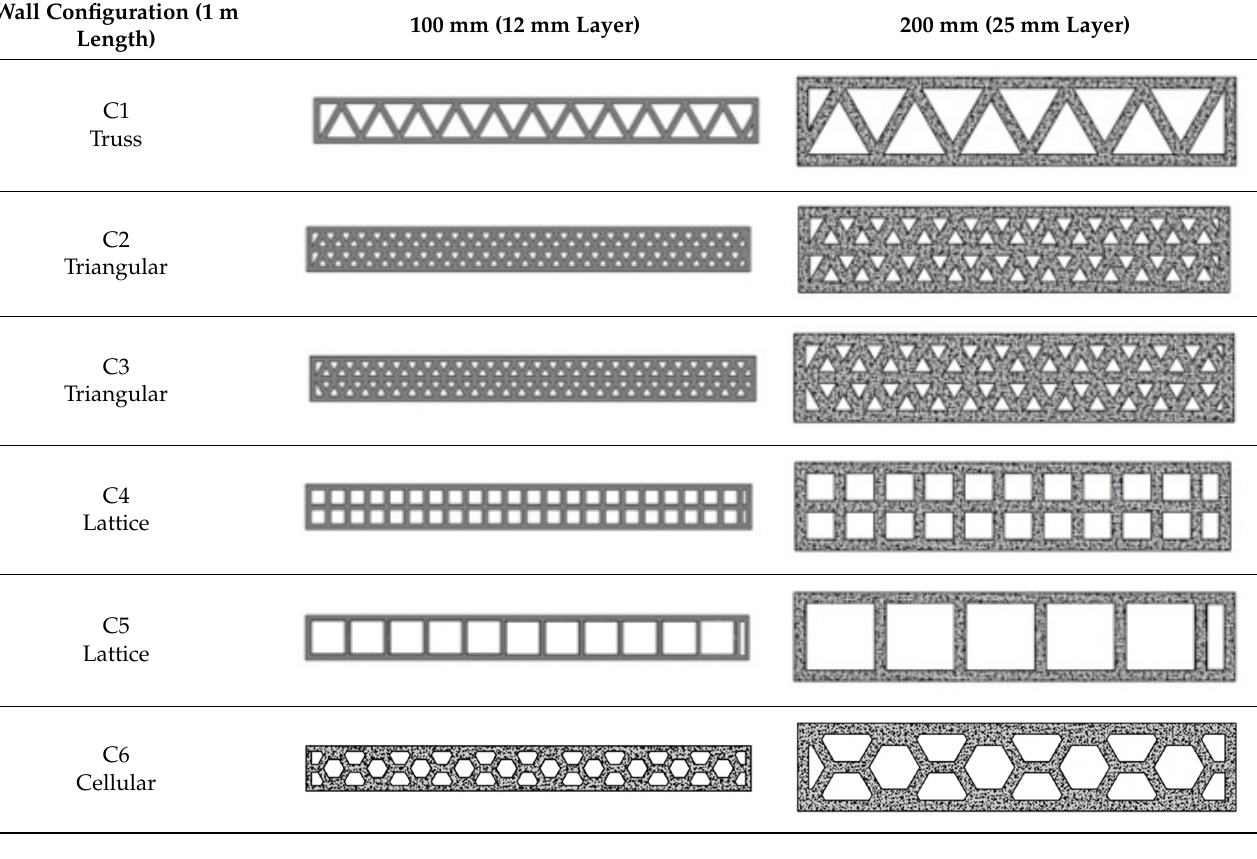
Table 3. Different cross-sectioned 3D-printed concrete wall configurations.